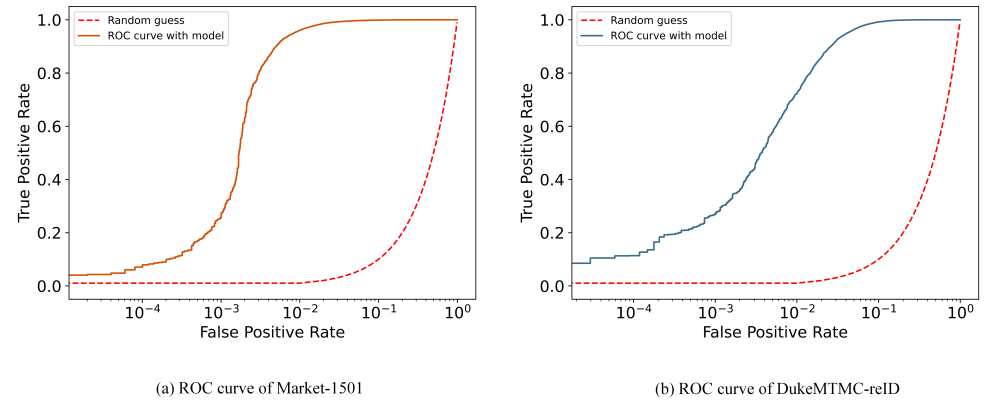
Figure 9. Receiver operating characteristic (ROC) curve on different datasets.